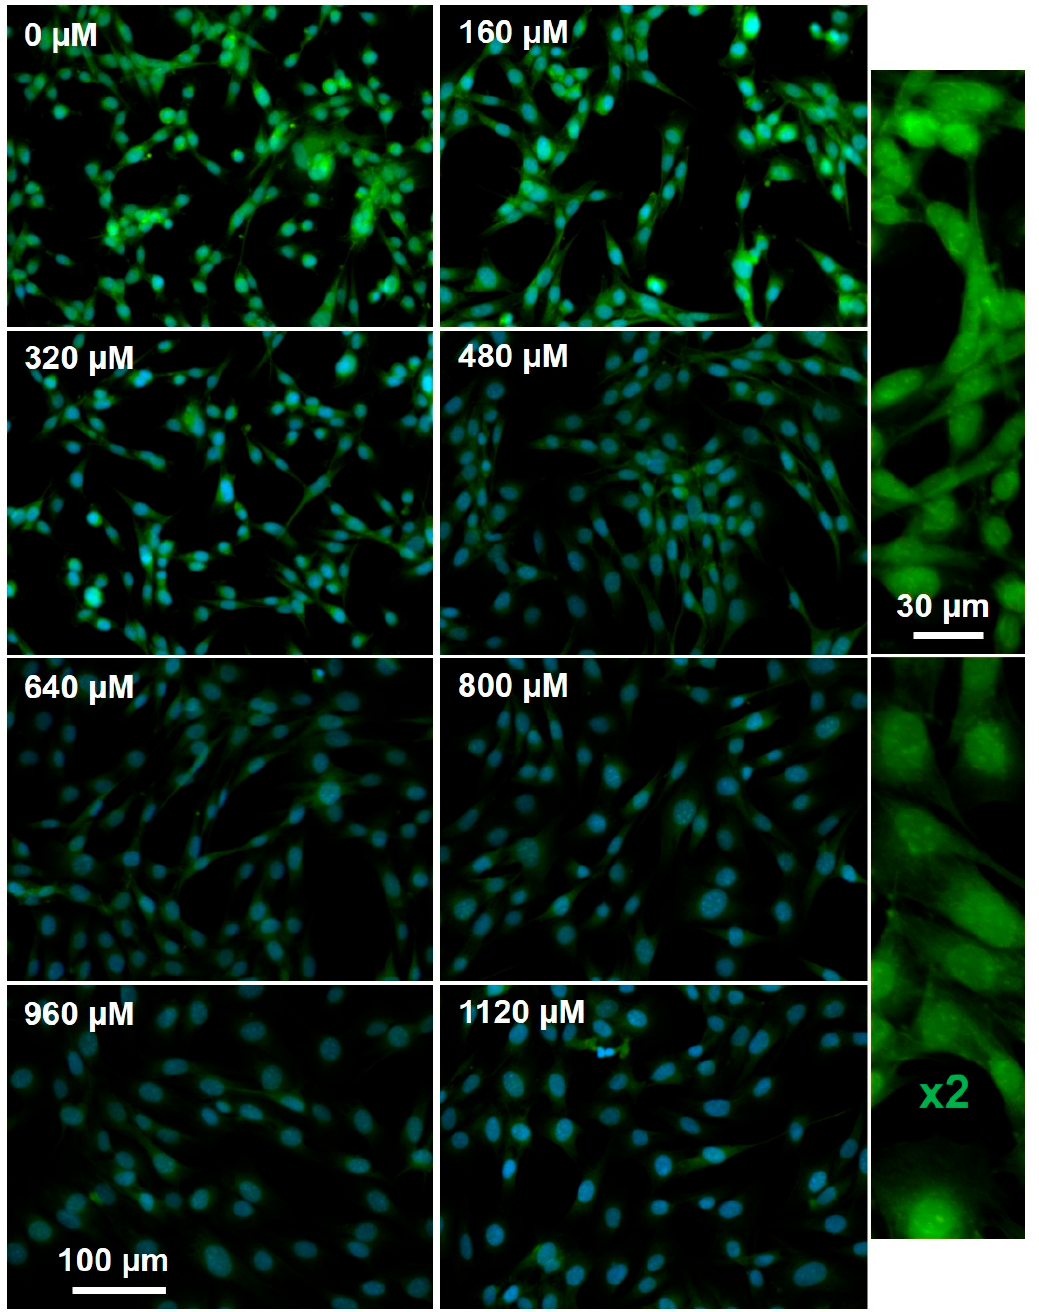
Figure 3. GBM157 cells incubated with increasing (0–1120 µ M) concentrations of TMZ and then labeled using 100 µ M O 6 PGG with Azido-PEG-FITC and